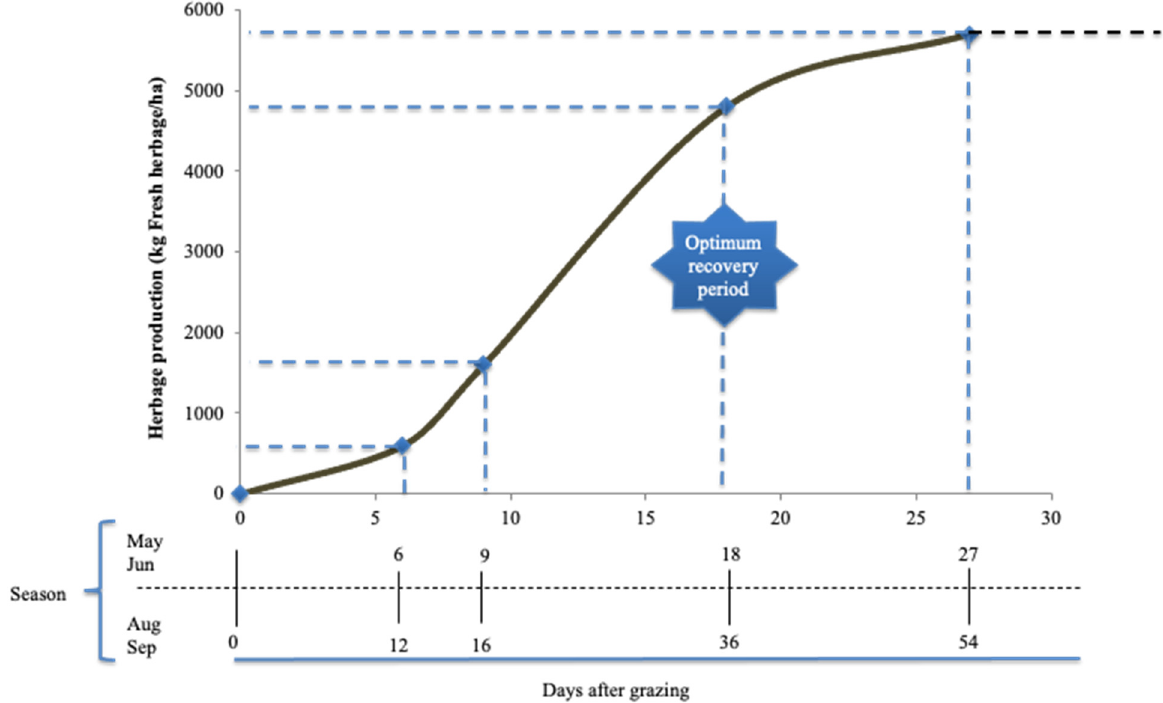
Figure 1. Plant growth curve (adapted from Voisin, [17]).